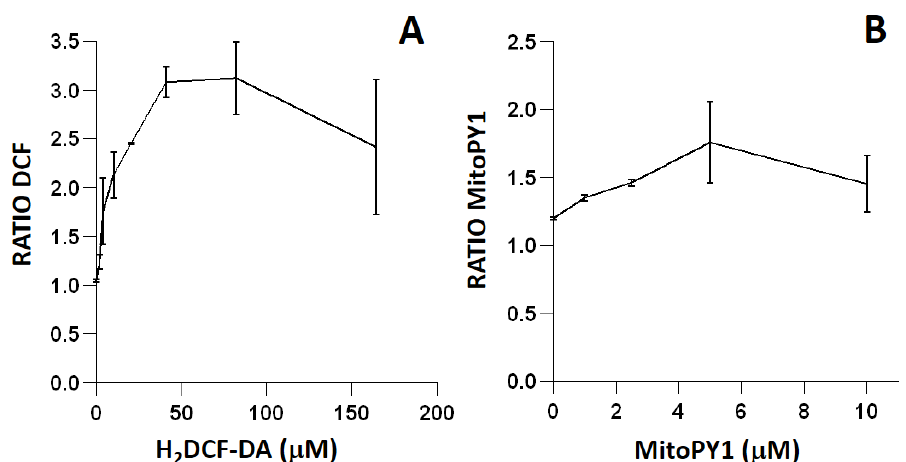
Figure 2. Titration of the fluorescent probes H 2 DCF-DA ( A ) and MitoPY1 ( B ) in strain IC188 exposed to 10 mM t-BOOH. Results are the mean ± SD (n = 3) of the fluorescence ratios of the products resulting from intracellular probe oxidation.